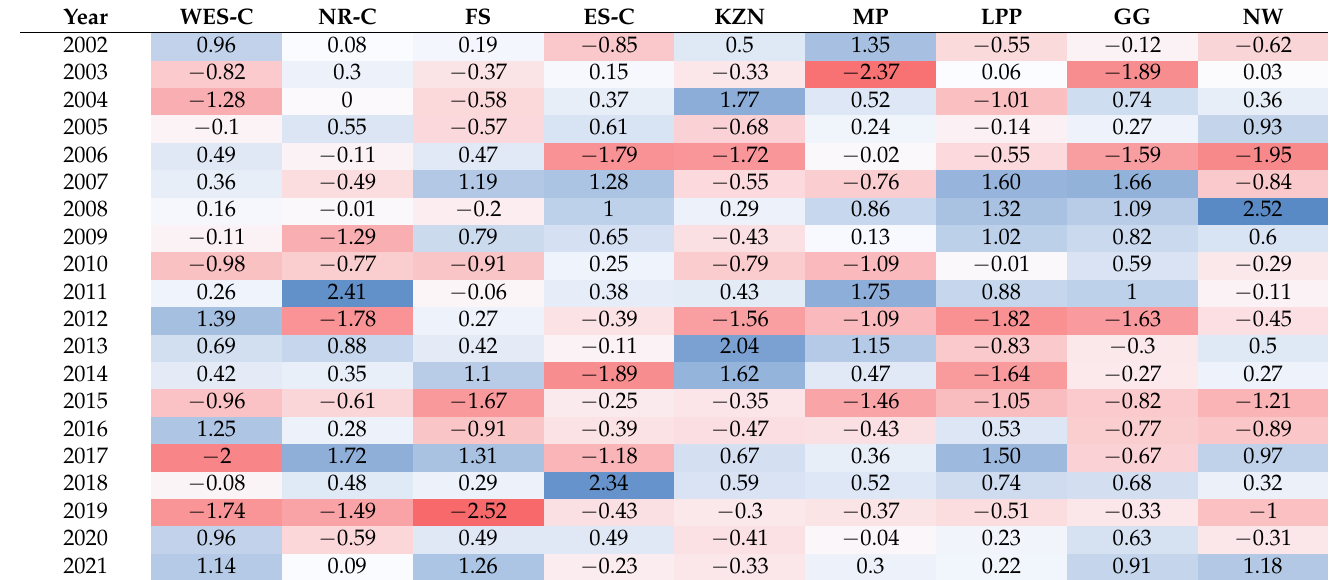
Table 5. Year-by-year comparison of SYRS SPI-3 changes in South African provinces from 2002 to